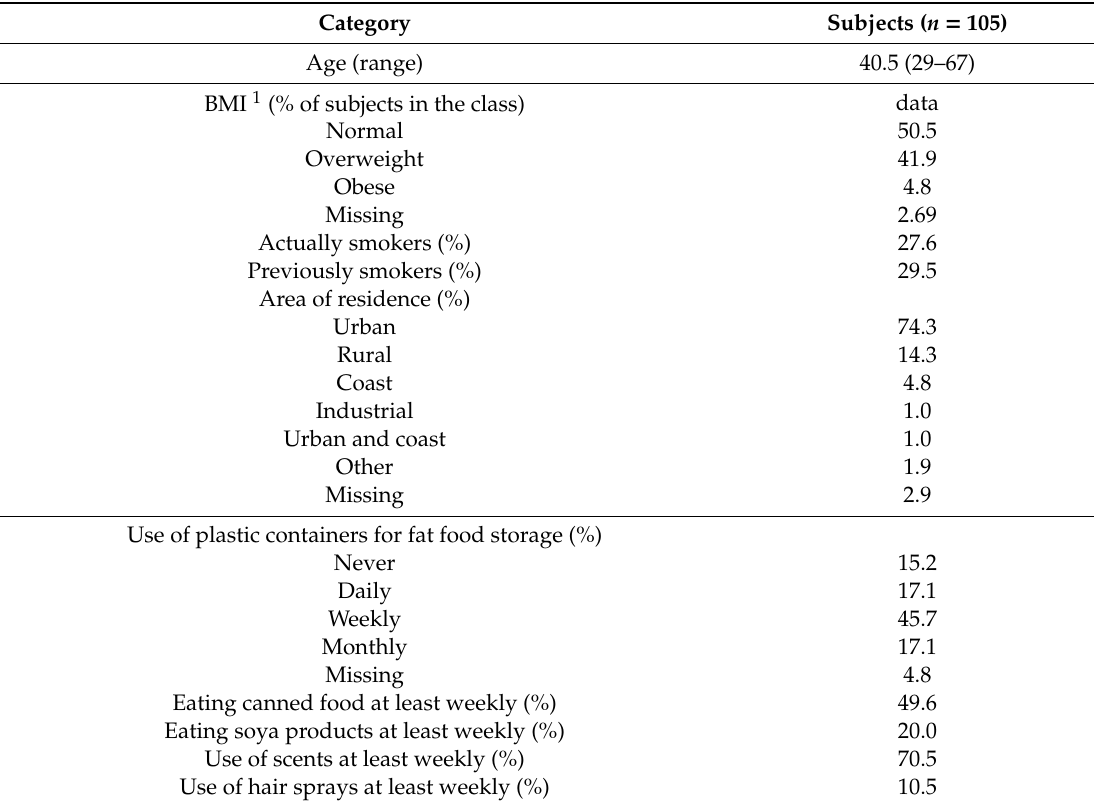
Table 1. Characteristics of the study